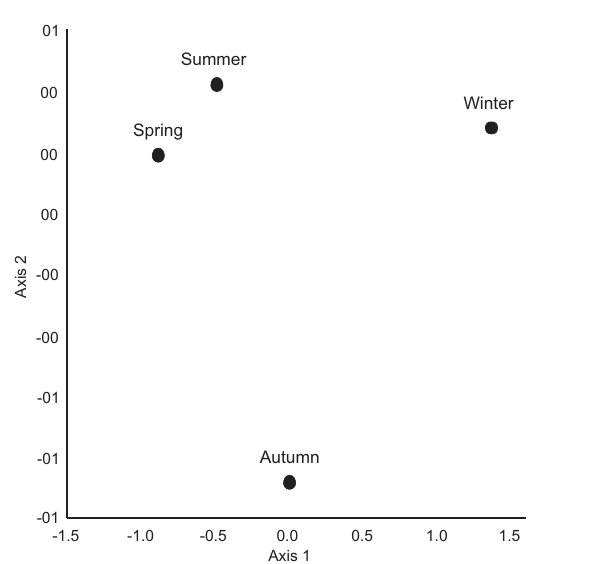
Figure 3. NMDS ordination indicating the community composi- tion of leaf-litter frogs during the four seasons sampled in the Reserva Natural Salto Morato, Guaraqueçaba. Stress =